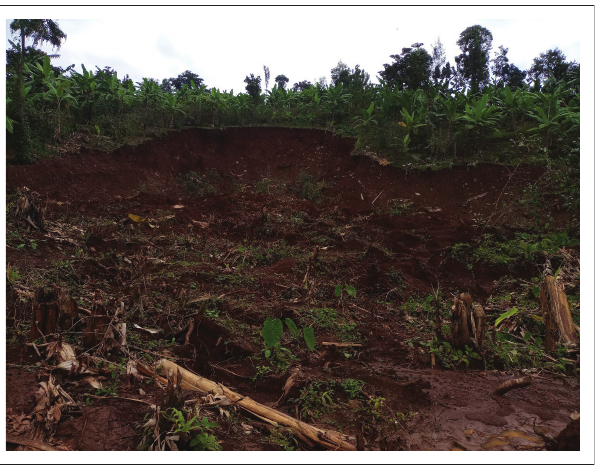
FIGURE 5: Landlside that occurred at 12:00 noon and then re-occurred at 15:00 covering villages of Mayila, Nabutatsi and Kikonyelo in Bududa district where more than seven households and a church were demolished including those of persons with disabilities as reported by the nearby locals and host families